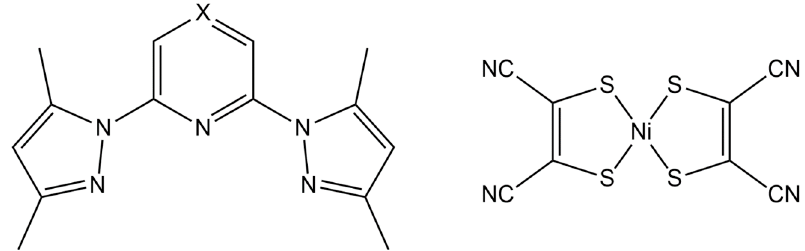
Table 1. Crystallographic data and collection parameters for compounds 1 and 2.